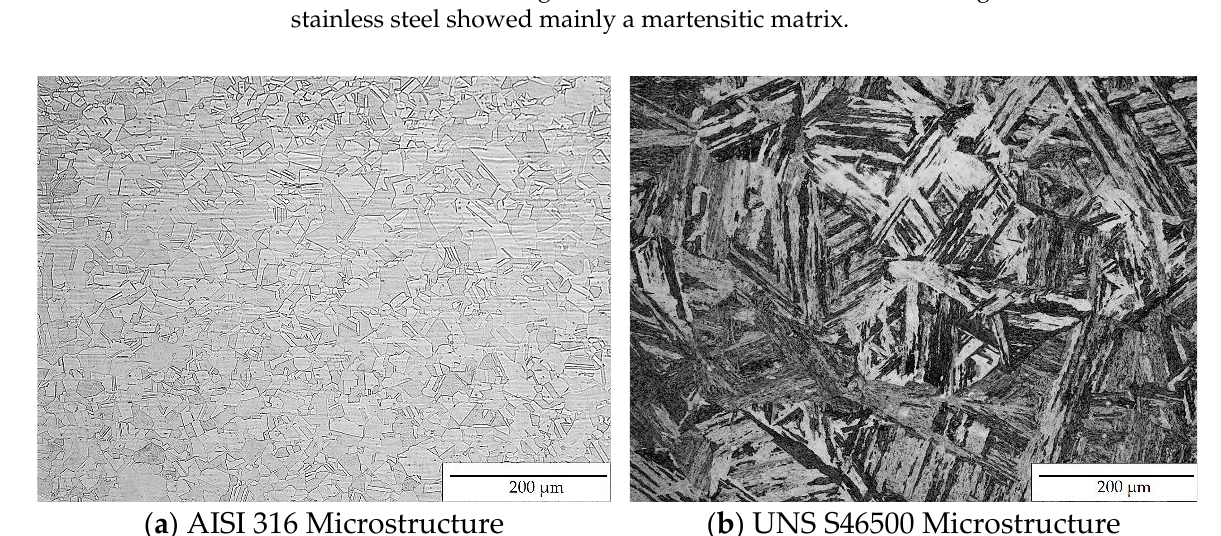
Figure 1. Stainless steel microstructural